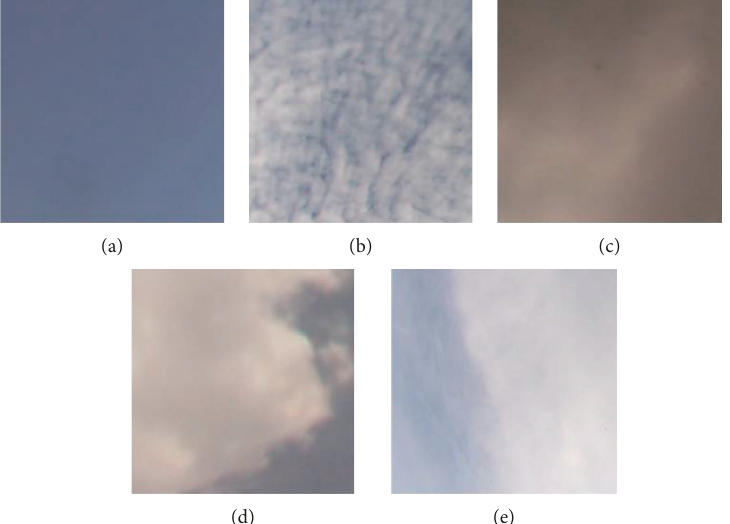
Figure 2: Sample images from the SWIMCAT dataset. (a) Clear sky. (b) Patterned clouds. (c) Thick dark clouds. (d) Thick white clouds. (e) Veil clouds.